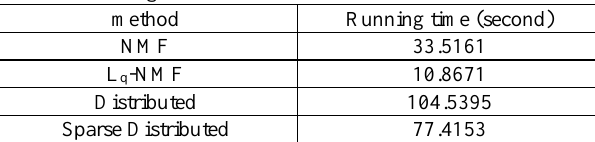
Figure 2. The SAD performance metric of 5 methods versus SNR, using random initialization and applied on synthetic data. SAD of the proposed algorithm is star-dashed line. Table 1. Comparison of running time between four algorithms, using VCA initialization and SNR=25dB.